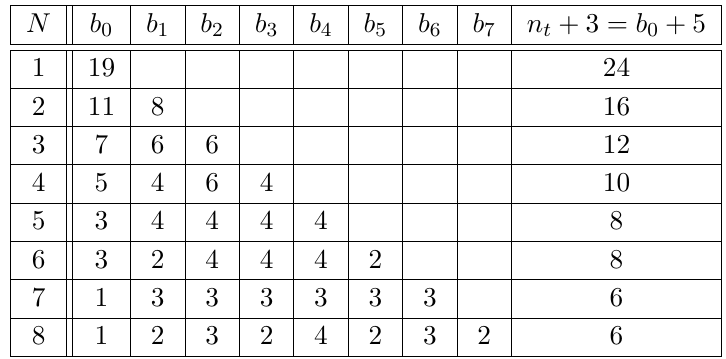
Table 4 . Hodge data on Z N orbifolds of K3 (cid:2) S 1 (cid:2) e S 1 . The numbers b s denote the number of anti-self-dual (1 ; 1) form transforming as g s . We note that number of tensor multiplets in six- e dimensional supergravity description is simply the number of g invariant anti-self-dual (1,1) forms e b 0 plus 2: n t = b 0 + 2. The plus 2 comes from the self-dual and anti-self-dual decomposition of the type IIB RR and NS-NS 2-form (cid:12)elds. The ratio of the 4d and 5d partition functions depends on n t + 3, which is equal to b 0 + 5. This information is listed in the last column. where ! (cid:13) ( y ) are the self-dual and anti-self-dual harmonic forms spanning the cohomol- ogy H 2 (K3) : On the elements on this cohomology, the abelian orbifold group of order N generated by g e